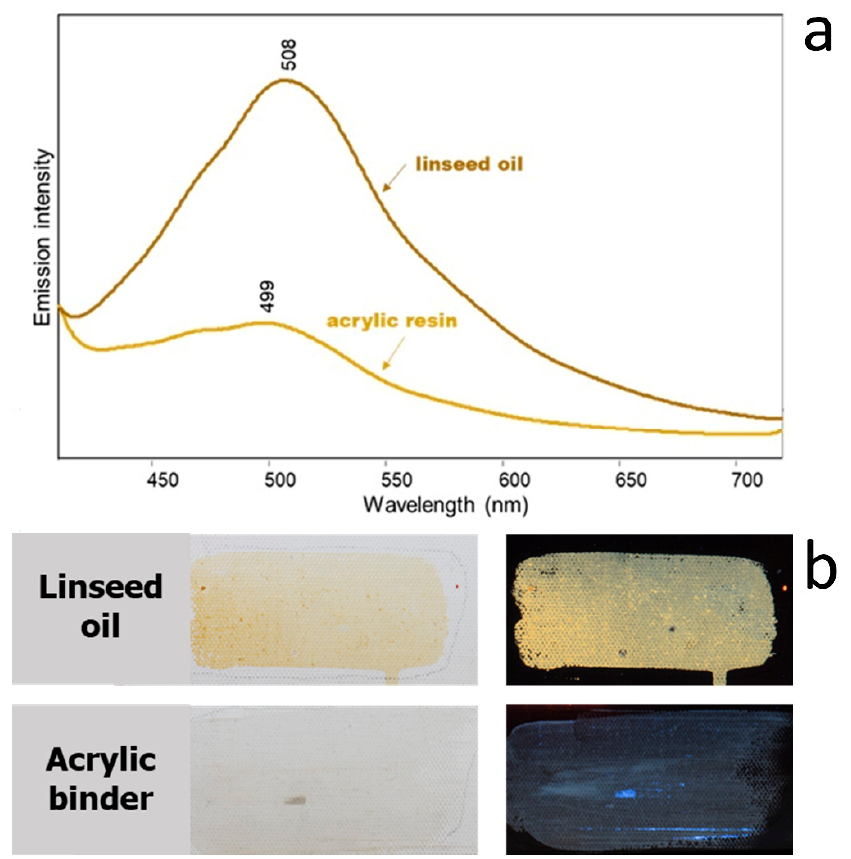
Figure 8. ( a ) Emission spectra ( λ exc 365 nm) and ( b ) visible and UVF images of linseed oil and acrylic resin spread on canvas.